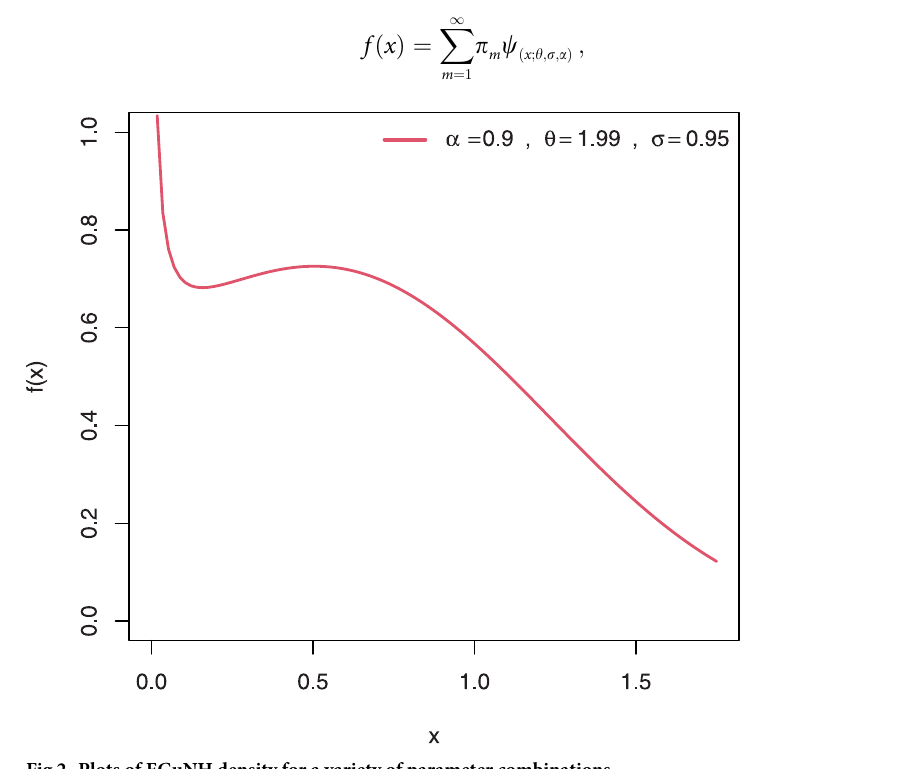
Fig 2. Plots of EGuNH density for a variety of parameter